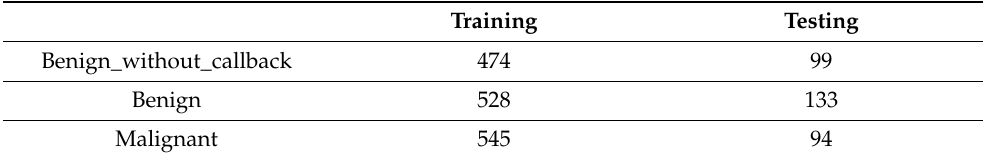
Table 1. The number of images used in each class.